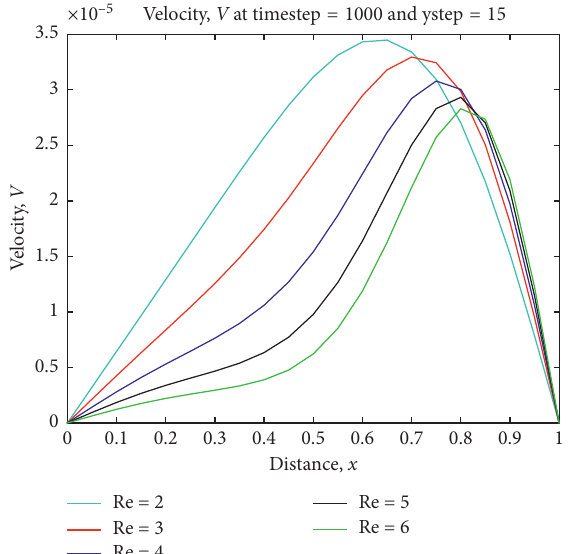
Figure 11: Graph of effects of the Reynolds number on secondary velocity